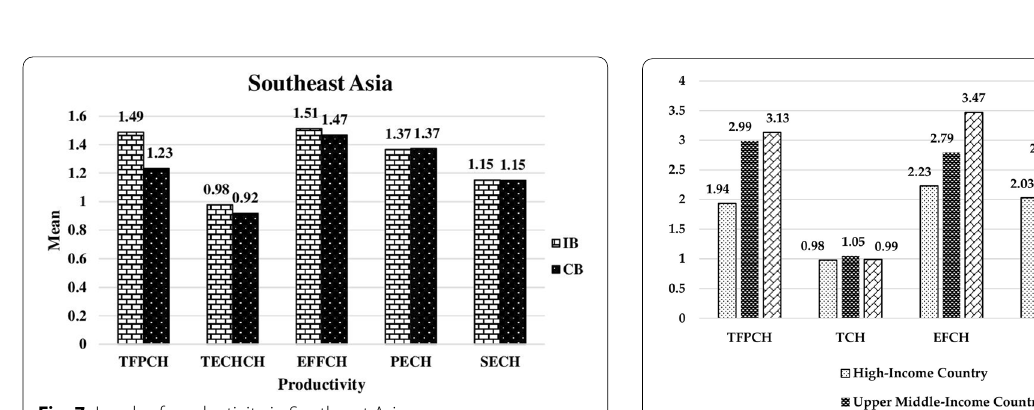
Fig. 7 Levels of productivity in Southeast Asia